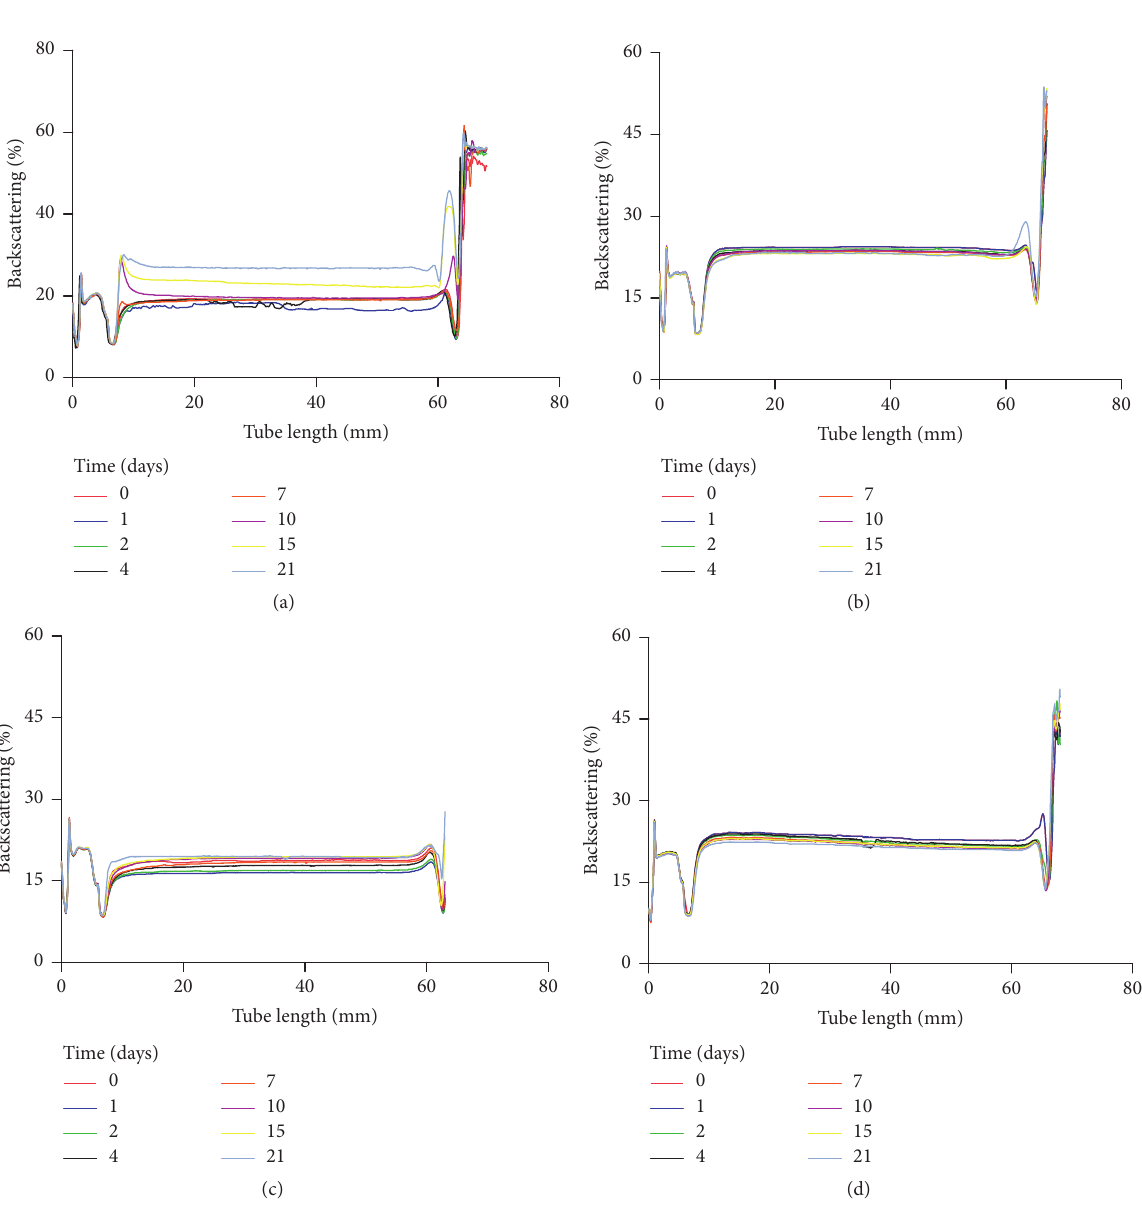
Figure 3: Backscattering profiles as a function of the tube length after 21 days in quiescent conditions for nanoemulsions prepared at 5 ∘ C with (a) CMC-olive oil (0.5 :5%), (b) CMC-olive oil (0.5 : 15%), (c) CMC-olive oil (0.75 :5%), and (d) CMC-olive oil (0.75 :